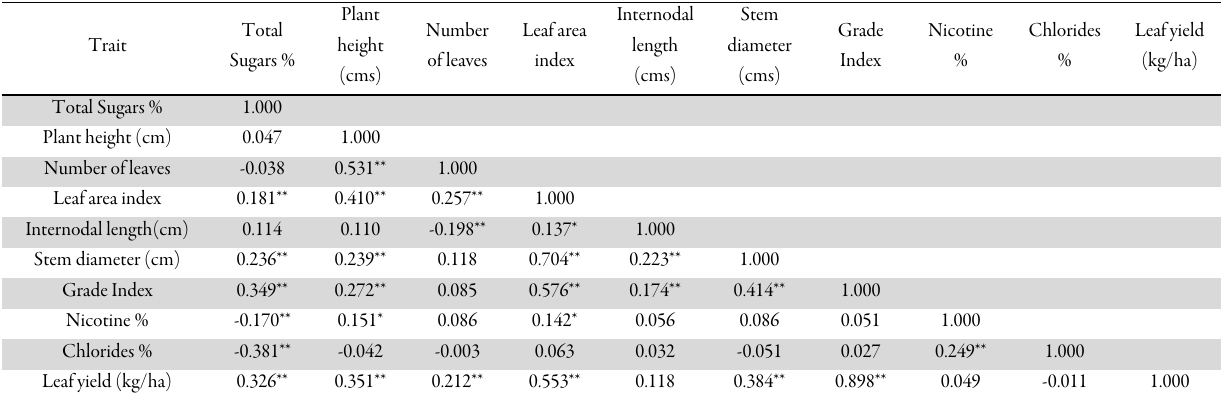
Table 2. Phenotypic correlations among traits in Multi-parent Advanced Generation Inter Cross (MAGIC) F 2 generations Trait